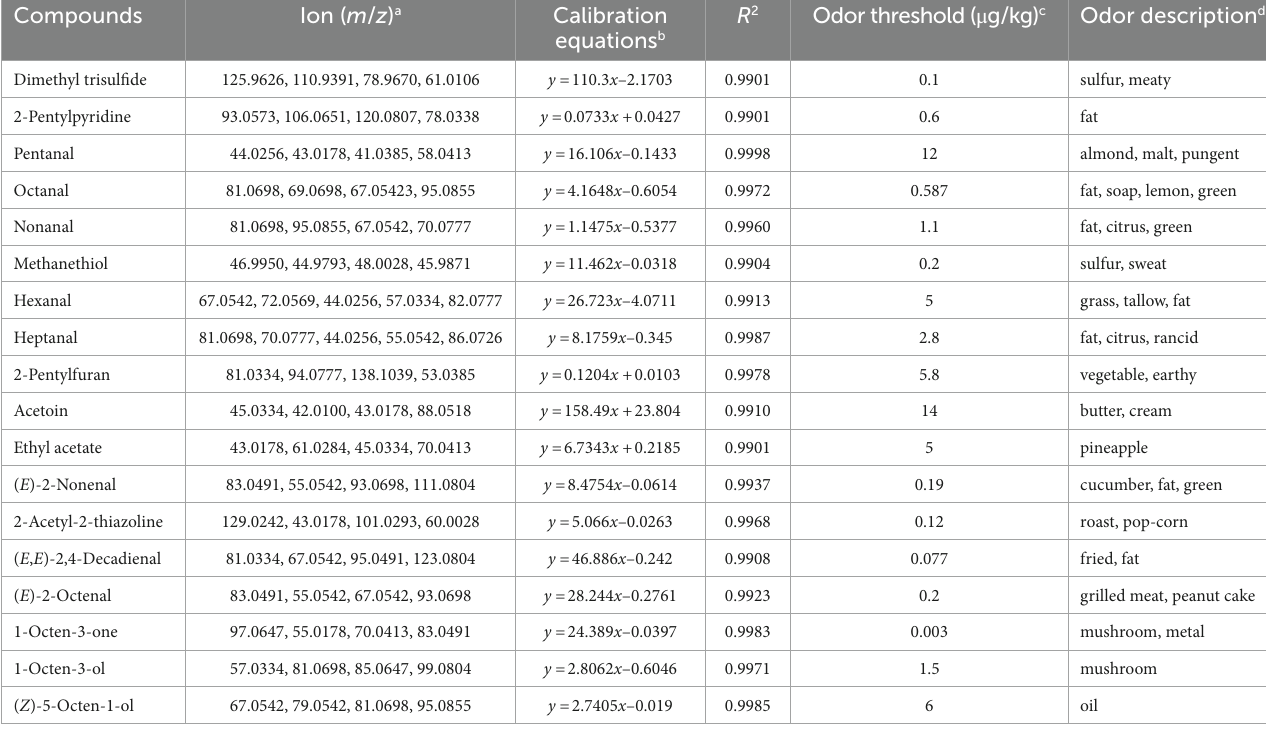
TABLE 4 Ions used for quantitation, calibration equations, coefficients of determination ( R 2 ), and odor threshold of 18 odorants in Hu and Tan sheep.